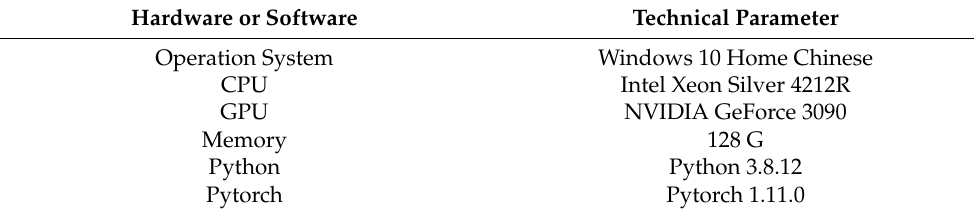
Table 3. Configuration of hardware and